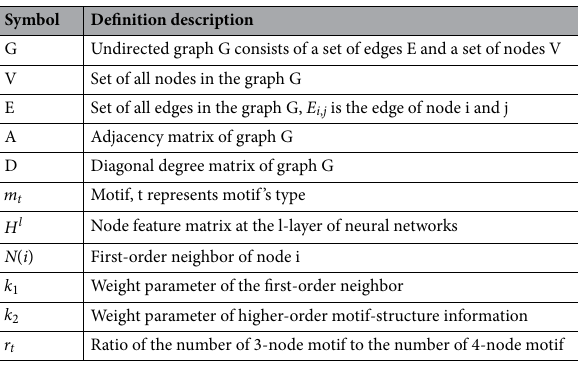
Table 1. Table of notations.